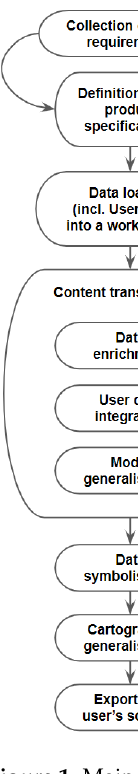
Figure 1. Main steps of the on-demand mapping process (extracted from